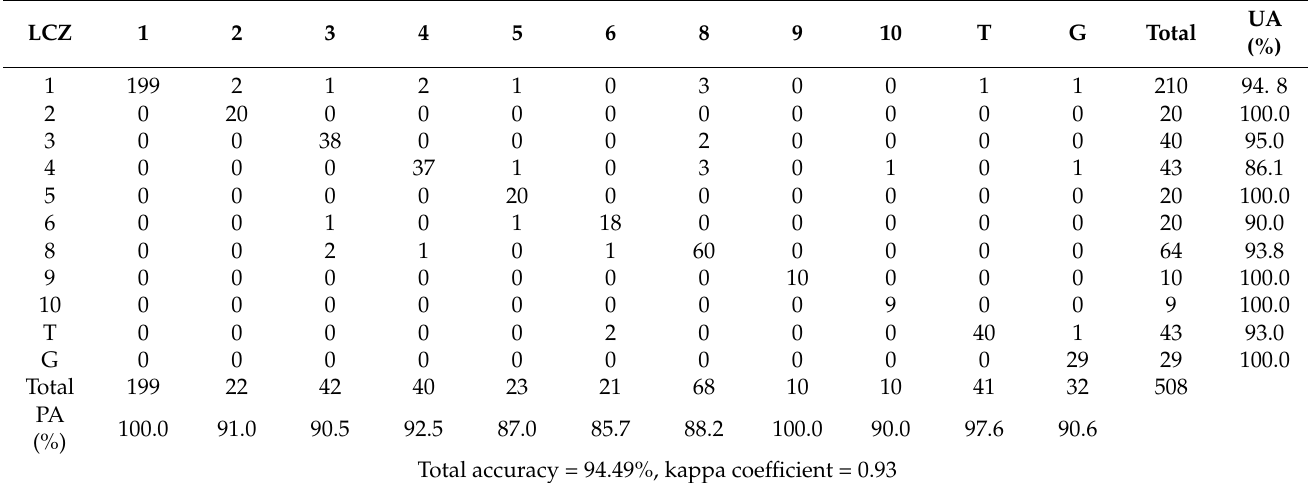
Table 4. Confusion matrix of LCZ classification results.